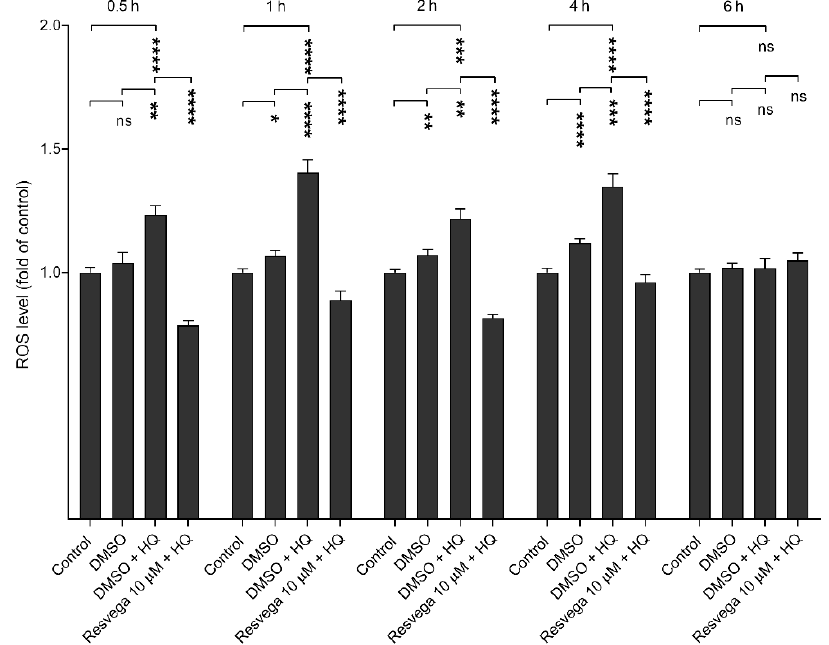
Figure 5. ROS production by hydroquinone (HQ) and the effect of Resvega (DMSO 0.5% v / v ) on it in ARPE-19 cells. ROS levels of untreated control cells were set to be 1 and other groups were compared to that. Results are combined from three independent experiments with six parallel samples per group in each experiment and shown as mean ± SEM. * p < 0.05, ** p < 0.01, *** p < 0.001, **** p < 0.0001, ns—not significant, Mann-Whitney U-test.